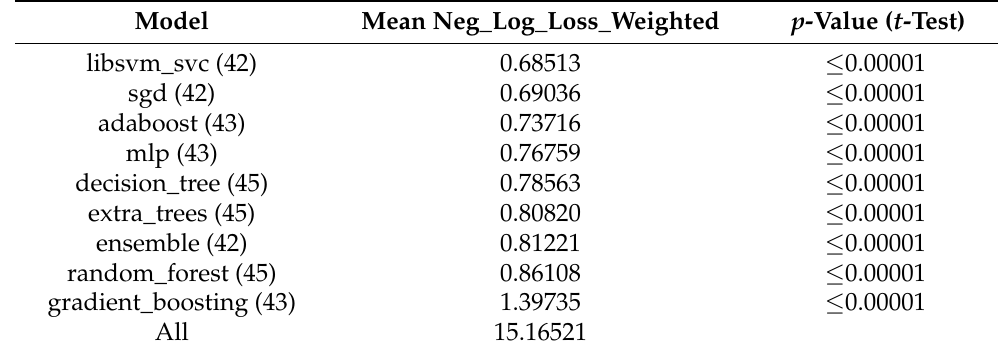
Table A13. Models with significantly better mean log loss